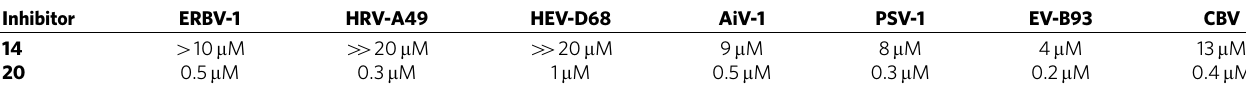
Table 2 | IC 50 values of inhibitors 14 and 20 towards seven viral 3C proteases. Inhibitor